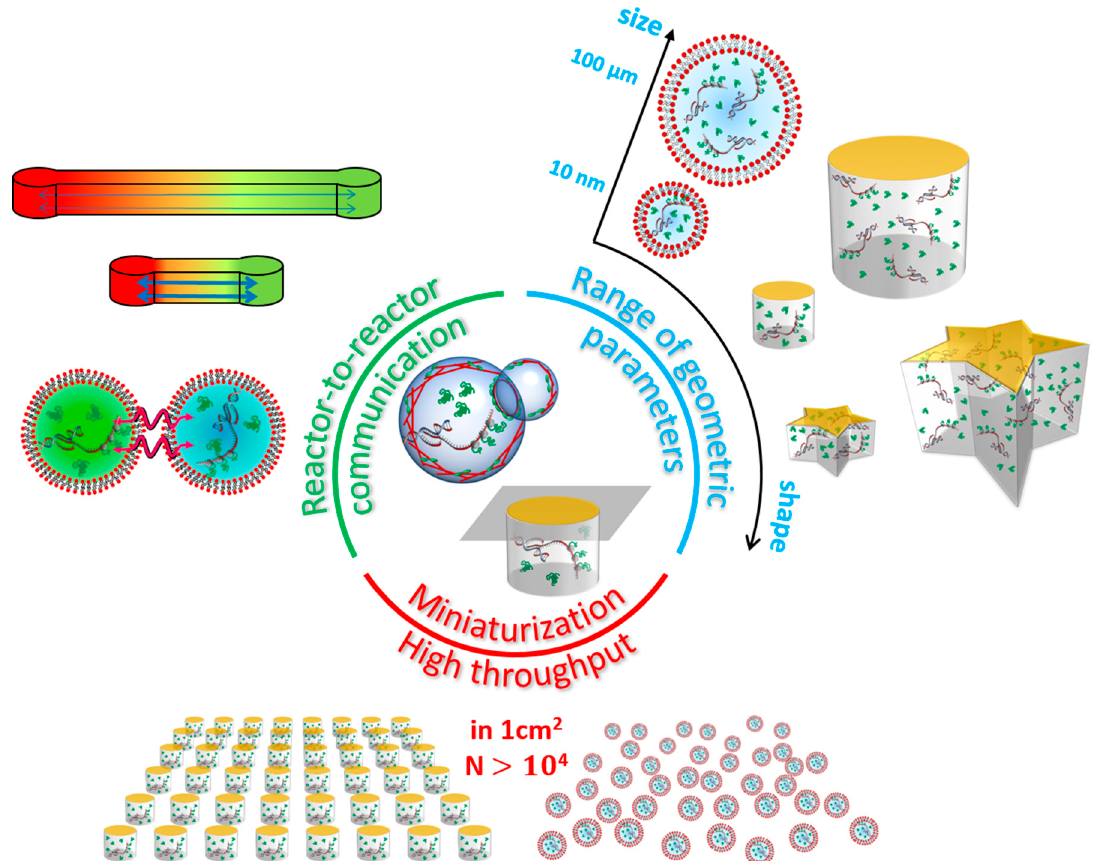
Figure 3. Artificial systems allow monitoring simultaneously very large populations of micro-reactors in very compact chips, with much less variability in the sample than in living systems. They also offer a significant flexibility in the control of the geometric parameters, as well as the interactions between individuals, without strongly perturbing the metabolism.